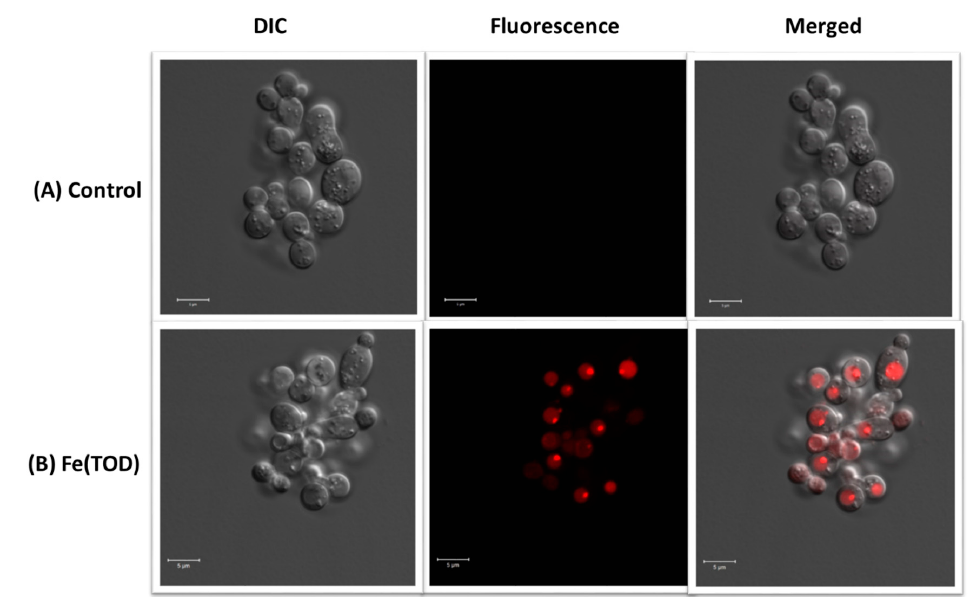
Figure 2. Confocal fluorescence microscopy images of the S. cerevisiae PC538 cells: ( A ) control cells and ( B ) Fe(TOD)-treated (10 mM) cells. DIC stands for differential interference contrast. Excitation was at 405 nm and emission was at 520–560 nm.